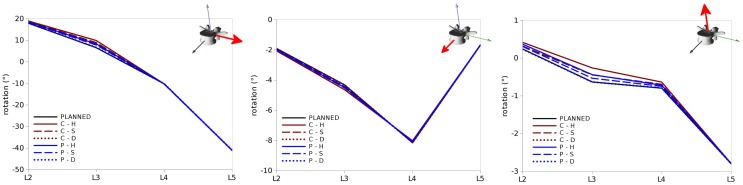
Vertebral rotations predicted for the test cases in the sagittal (left), coronal (center) and axial (right) planes (in each panel around the axes highlighted in red) in the six configurations “C–H,” “C–S,” “C–D,” “P–H,” “P–S,” and “P–D”. “PLANNED” represents the vertebral orientations of the desired correction.